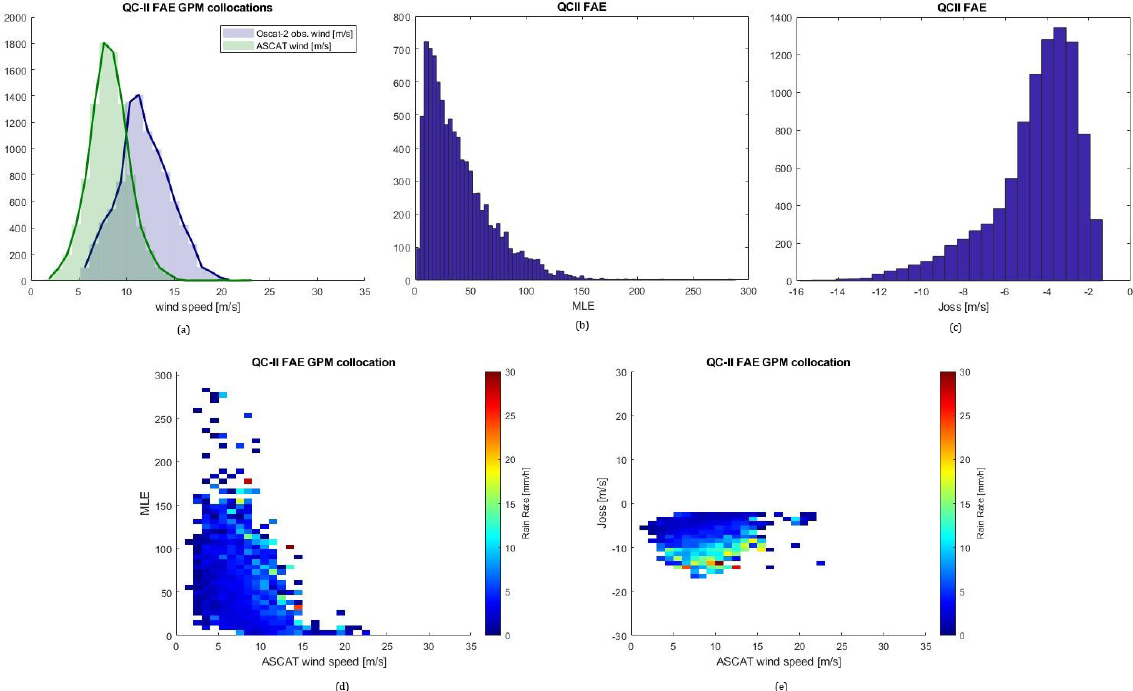
Figure 2. Collocated wind speed distributions in the QC-II FAE set (a) , corresponding MLE distribution of OSCAT-2 (b) , Joss (c) , collocated rain rates with reference to MLE (d) and Joss (e)